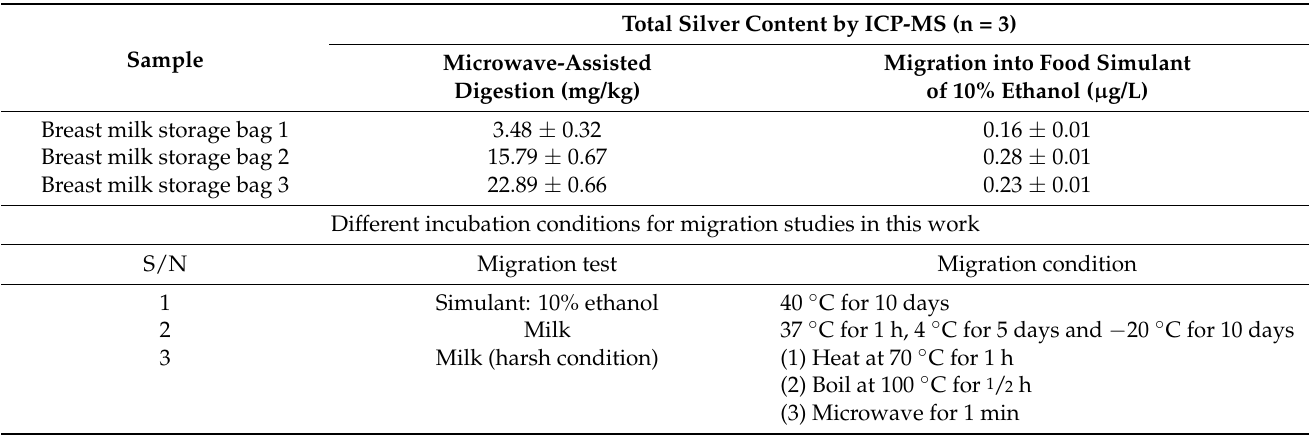
Table 4. Determination of total silver content from breast milk storage bags under various scenarios as well as summary of incubation conditions for migration studies in this